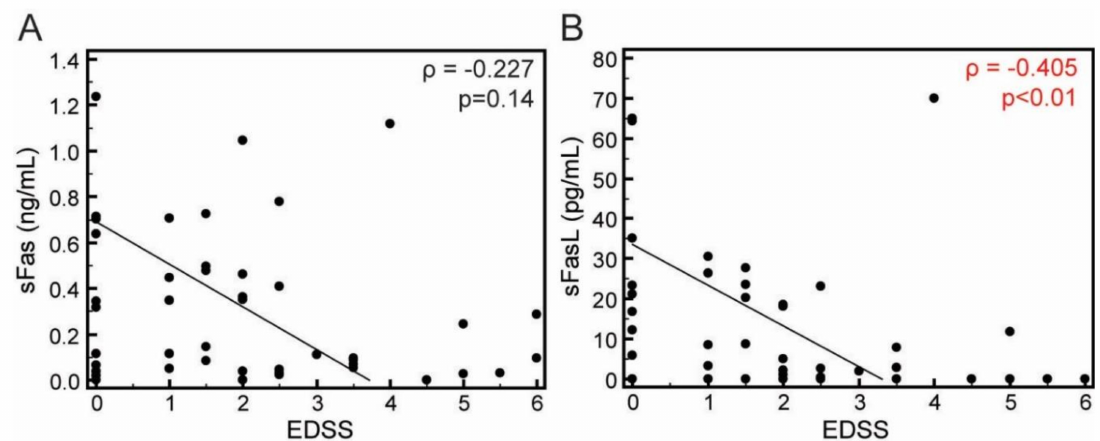
Figure 3. Association of concentrations of the sFas ( A ) and sFasL ( B ) in the sera of patients with RRMS with their EDSS score ( N = 44). Concentrations of sFas and sFasL were measured using cytometric bead-based arrays (LEGENDplex, Biolegend). Markers represent individual patients’ values; p values, Spearmans rank correlation ρ , correlation coe ffi